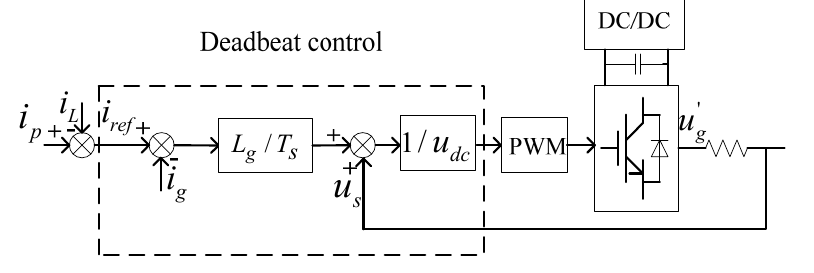
Figure 8. Control frame of system grid-side converter.